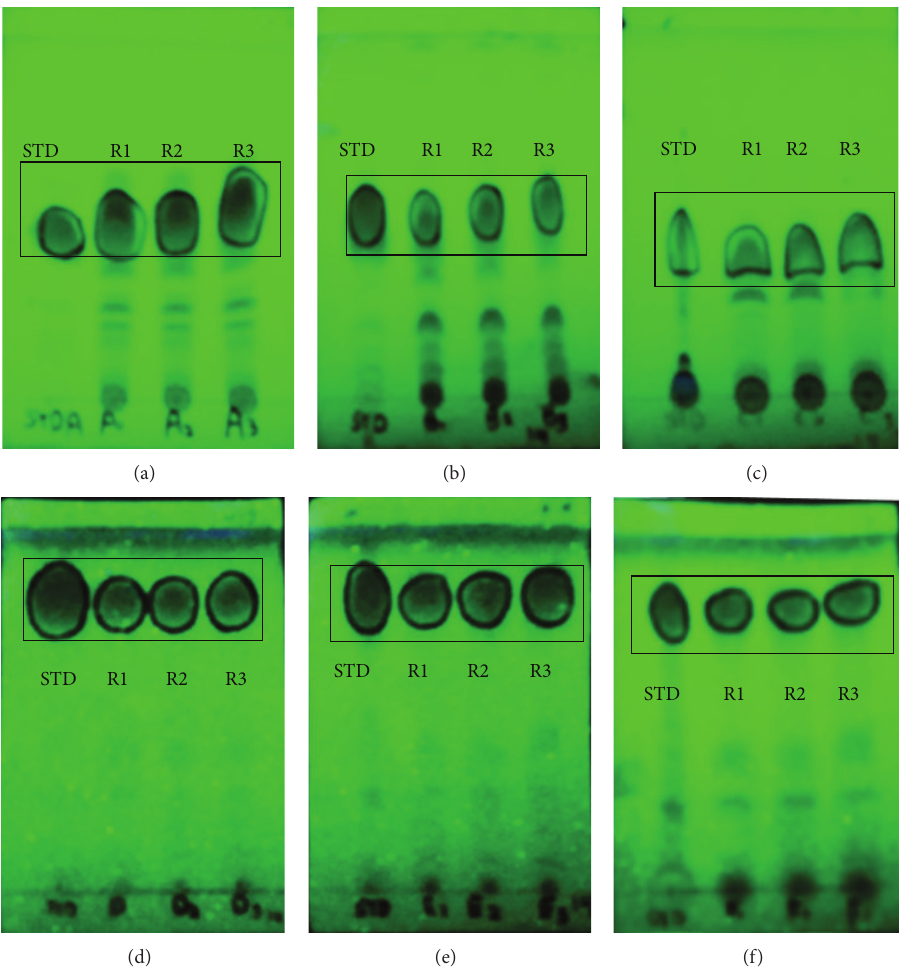
Figure3:Visualizationofrotenonemigrationmarkersoffivedifferenttypesofbinarysolventsystemsusedat14hrsofextraction.Themarkers were visualized on the alumina-based TLC plate under UV light of 254 nm. (a) Acetone; (b) [BMIM] Cl; (c) [BMIM] Oac; (d) [BMIM] NTF2; (e) [BMIM] OTF; and (f) [BMP] Cl. The dark circled markers of STD and R (R1, R2, and R3) represent the rotenone standard and replication of each binary solvent systems